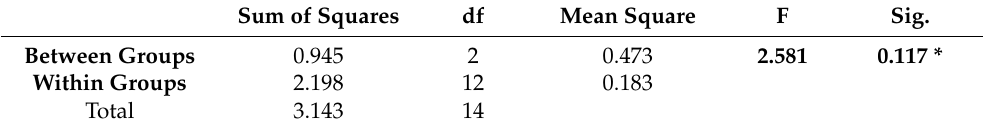
Table 9. The comparison between antioxidant methods with ANOVA Test (ABTS/DPPH/FRAP). Sum of Squares df Mean Square F Sig. Between Groups 0.945 2 0.473 2.581 0.117 * Within Groups 2.198 12 0.183 Total 3.143